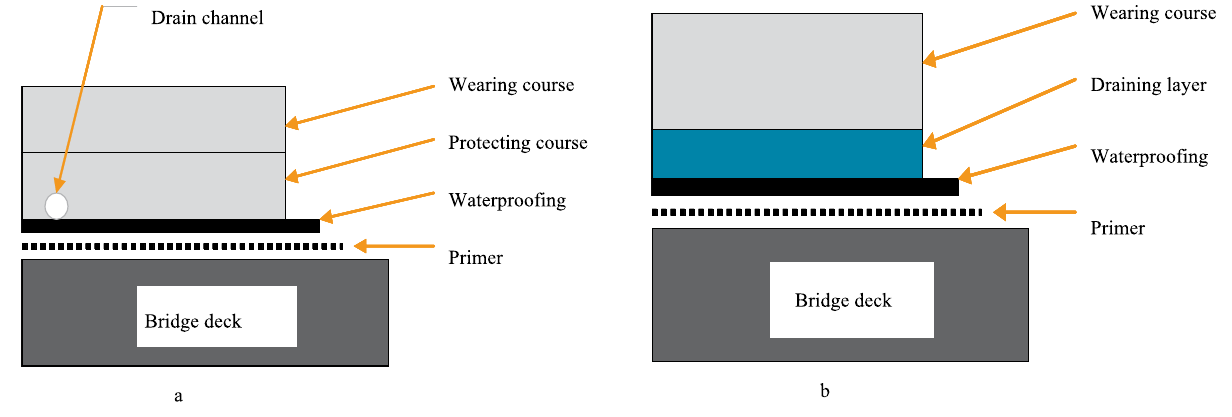
Fig. 2. Draining systems in bridge deck pavements: a – traditional system; b – new system proposed in this